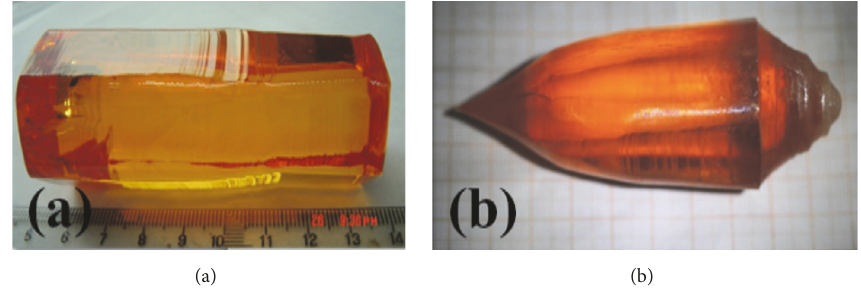
Figure 2: The photos of LGS and LGN crystals grown by Czochralski’s